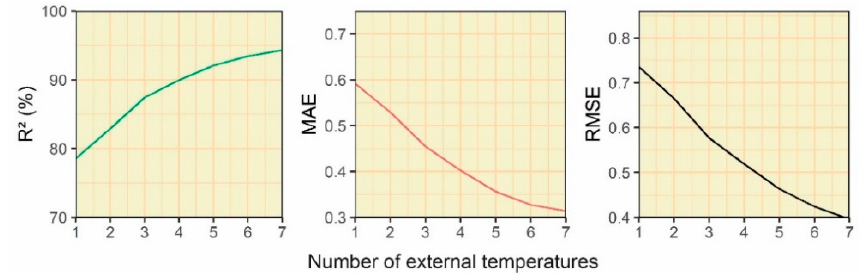
Figure 10. Influence of the number of the external temperatures used on the MLR model of A Gándara. Values obtained from the training of the model of the upper limit.